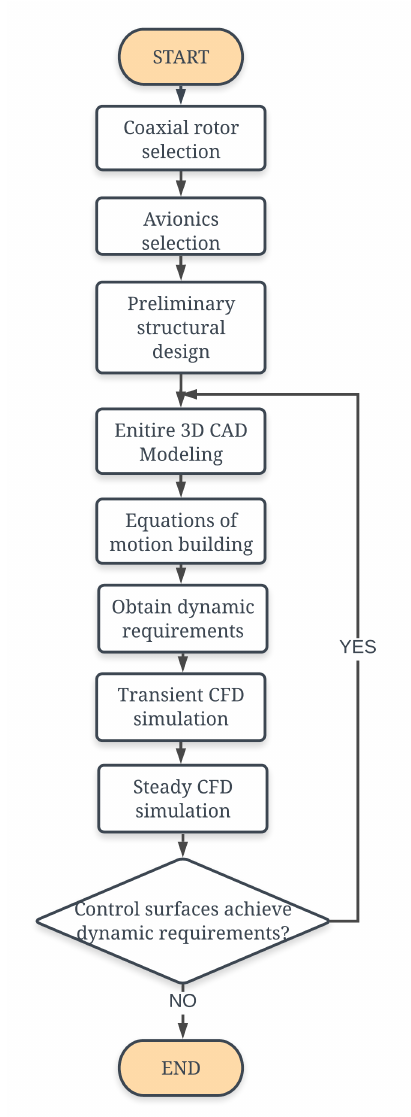
Figure 2. Flowchart used for MCR UAV v3.0